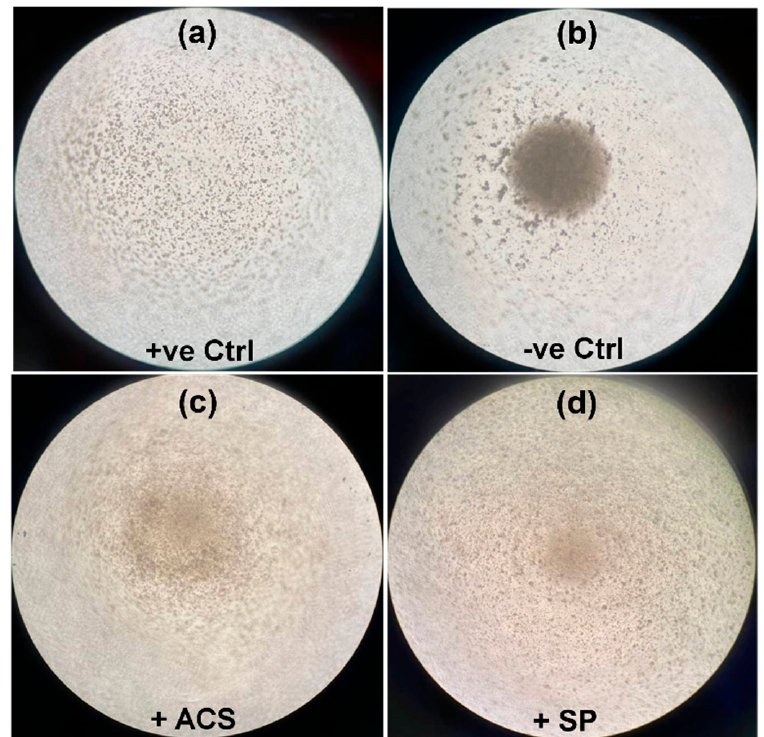
Figure 2. Images representing the cell proliferation condition observed under light microscopy. Representative images of an overview observation on T cells proliferations are shown in the panel. The proliferated cells in ( a ) the positive control well (+ve Ctrl) appears as scattered distribution of cells whereas ( b ) the unstimulated cells (-ve Ctrl) accumulated at the bottom of the U-shape well. Increased clumping of cells indicates no cell proliferation found in ( c ) ACS treated group more than ( d ) SP. The cells were then immunostained and quantified using flow cytometry analysis. All panels were the images captured at 40X magnification under the light microscope. Abbreviations, +ve Ctrl; positive control, -ve Ctrl; negative control, ACS; Autologous conditioned serum, SP; Sham plasma. In flow cytometry analysis, T cell proliferation was assessed by calculating the per- centage of EdU + (Alexa Fluor™ 448) within the gated CD5 + population. Because the T cell activity may vary between individual dogs, T cell proliferation suppression was calculated as mentioned previously in Methods. Flow cytometry gating area and representative percentage calculation were demonstrated in Figure